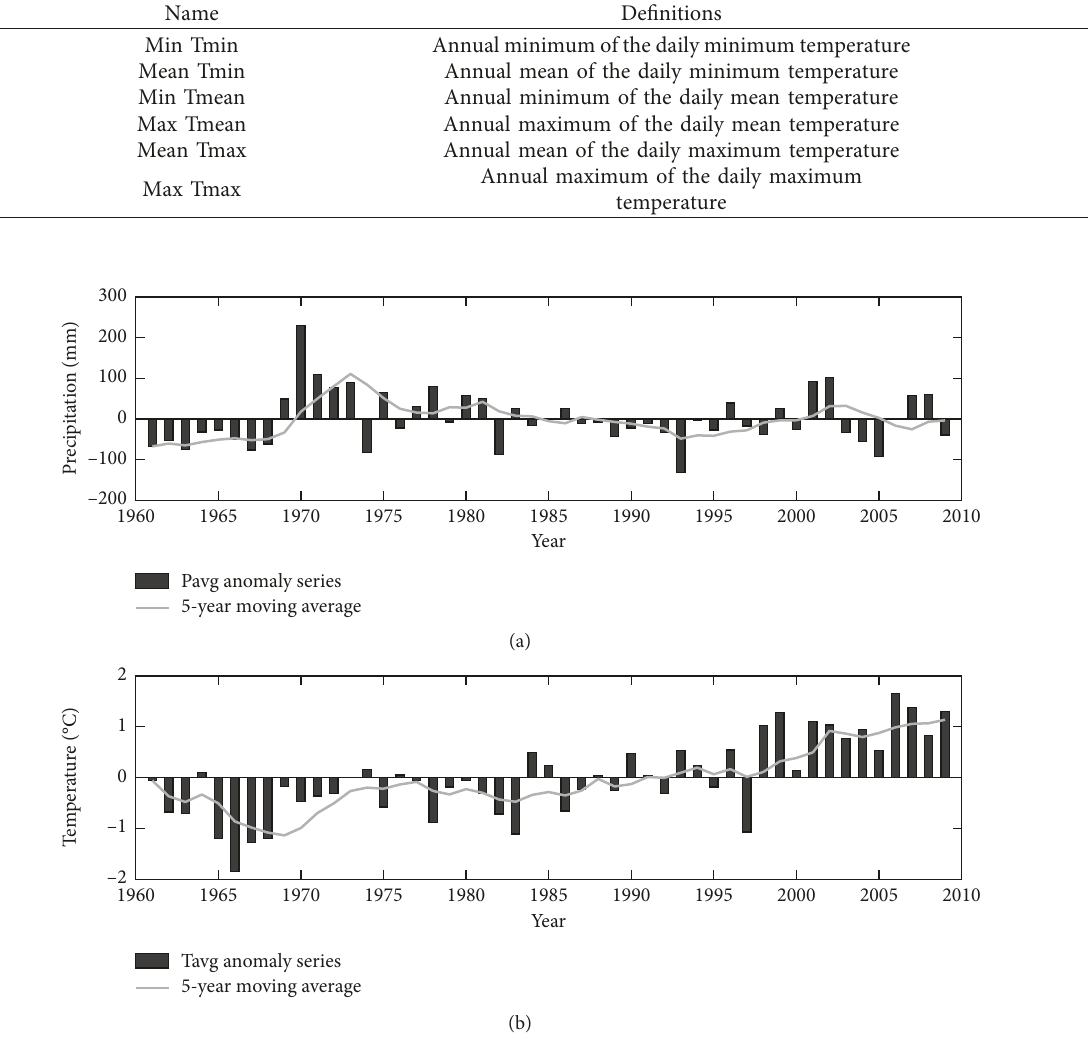
Figure 2: Pavg (a) and Tavg (b) anomaly series with their 5-year moving average during 1961–2009 over the upper reach of the